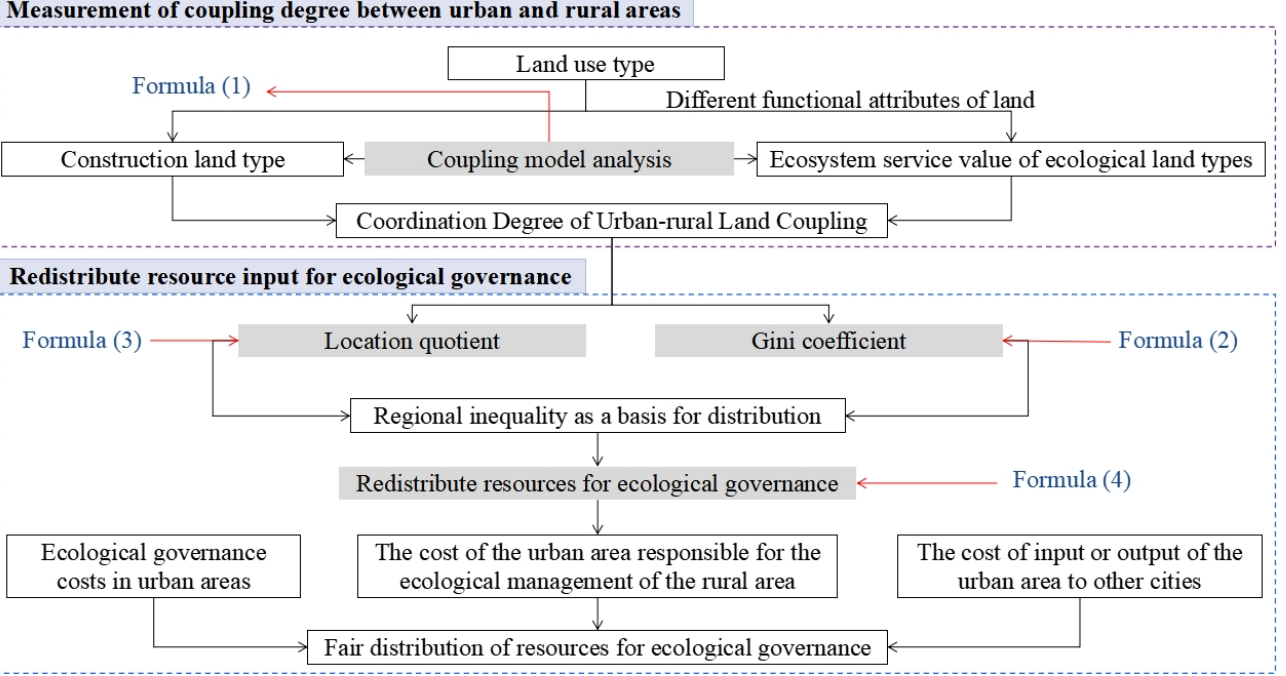
Figure 2. The research framework for the allocation of ecological governance resources.